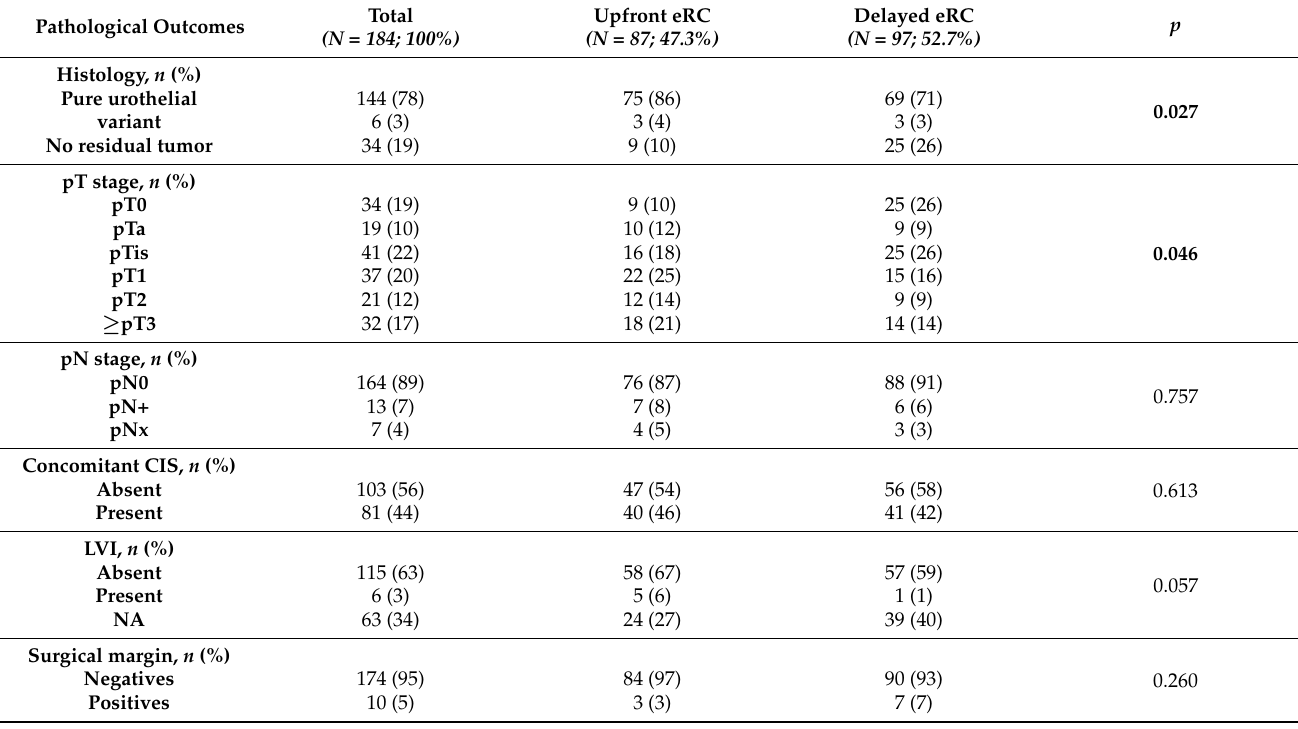
Table 5. Pathological outcomes of included patients treated with upfront or delayed eRC for HR- NMIBC. Bold: It is a significant